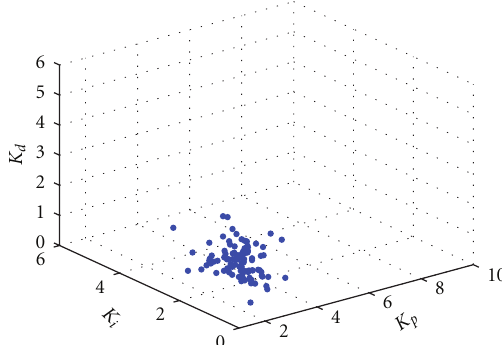
Figure 13: The Intermediate search space of parameters ( K best p , K best K best i , d ).